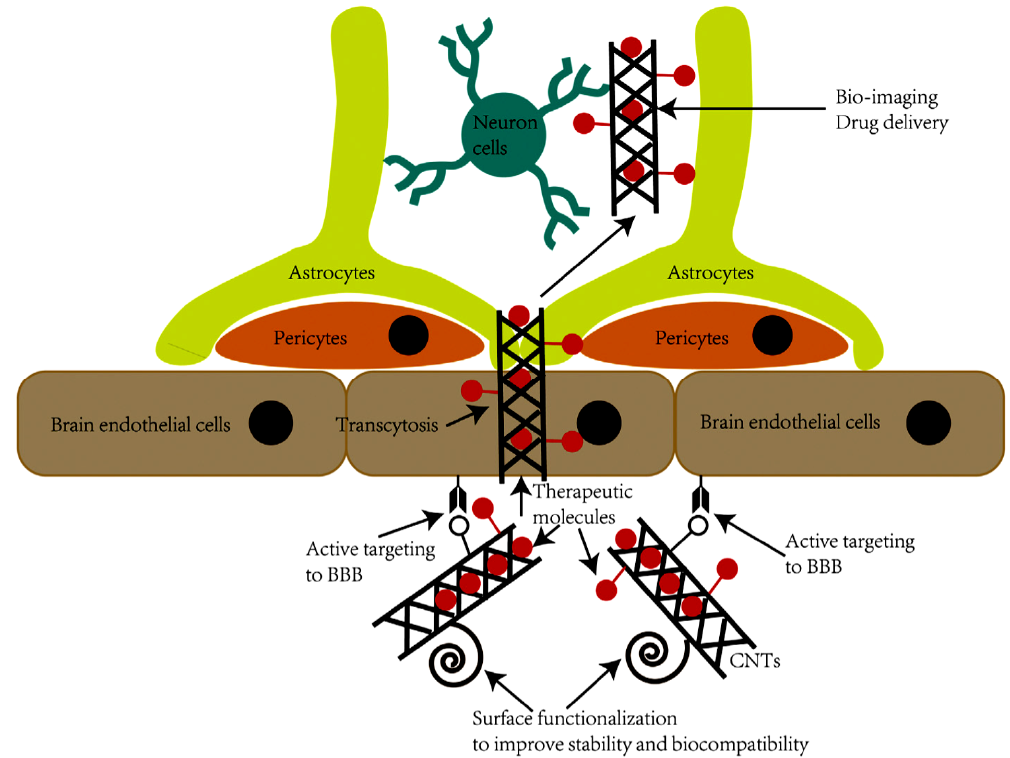
Figure 3. The strategy of the utilization of carbon nanotubes (CNTs) to cross the blood brain barrier (BBB). CNTs could be functionalized to increase the stability, biocompatibility, and active targeting of CNTs to BBB and nerve cells. Functionalized CNTs could effectively penetrate BBB and enter CNS for bio-imaging and drug delivery [59]. Reprinted with permission from Elsevier.